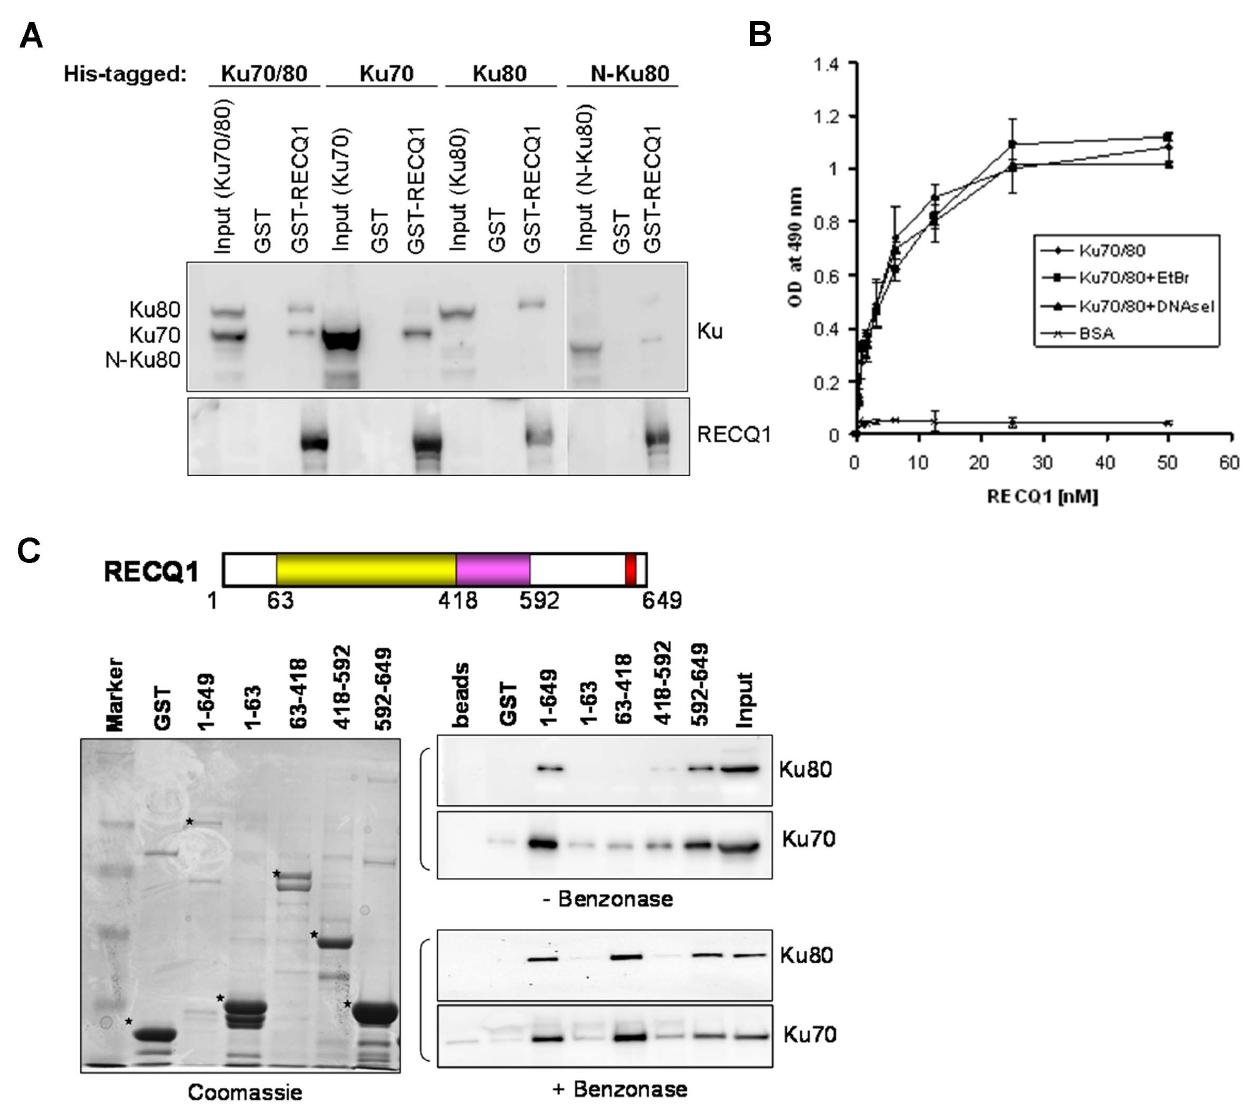
Figure 2. A direct physical interaction between RECQ1 and Ku70/80 invitro . A. RECQ1 directly interacts with Ku70 and Ku80. GST or GST fused-full length RECQ1 was incubated with bacterially expressed Ku70/80, Ku70, Ku80 or N-Ku80 (lacking the C-terminus amino acid residues 565– 732) followed by extensive washing of the beads, SDS-PAGE, and Western transfer. The blots were probed separately with anti-His (for Ku detection) and anti-RECQ1 antibodies. Input lanes account for 10% of the bacterial lysate expressing Ku protein used in the pull-down reactions. B. Recombinant RECQ1 and Ku70/80 proteins interact directly as shown by ELISA. Either BSA or purified recombinant Ku70/80 was coated onto microtiter plates. Following blocking with 3% BSA, appropriate wells were incubated with the indicated concentrations of recombinant RECQ1 (0–50 nM) for 1 h at 30 u C. Parallel wells contained DNaseI (100 U/ml) or EtBr (50 m g/ml) in the binding step to test for DNA-mediated protein interaction. Following washing, Ku70/80-bound RECQ1 was detected by ELISA using anti-RECQ1 antibody. The values represent the mean of three independent experiments performed in duplicate with SD indicated by error bars. C. GST alone or GST-RECQ1 fragments (as indicated) bound to glutathione beads were incubated overnight at 4 u C with HeLa extract (500 m g) that was either untreated or pre-treated with benzonase. After extensive washings, the bound Ku70/80 was eluted with SDS sample buffer and analyzed by Western blot using anti-Ku70 and anti-Ku80 antibodies (right). Coomassie staining of the eluted proteins was done to test expression of various GST-fusion fragments of RECQ1 (left). GST-RECQ1 proteins are marked by asterisk. Marker, protein molecular weight marker.